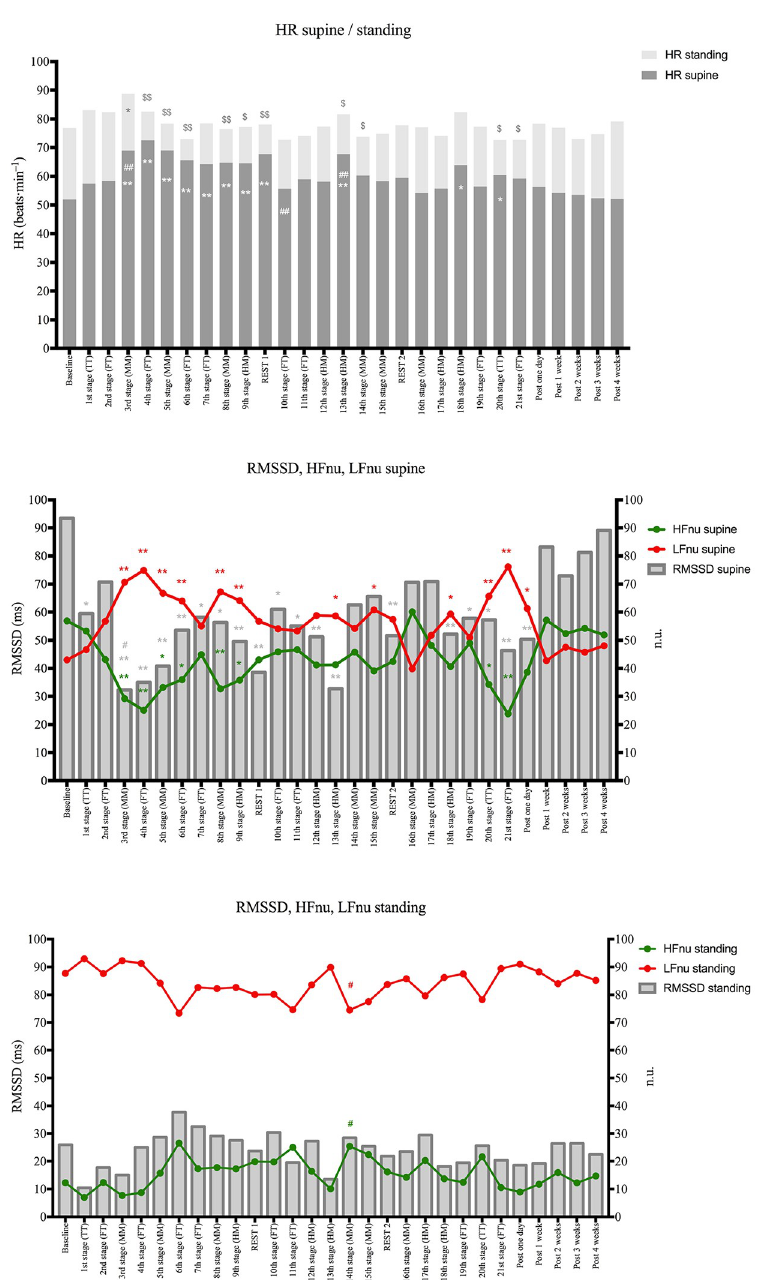
Fig 1. Evolution of Heart rate and HRV parameters stage by stage. Data are presented as mean group values. Absolute HR values different from baseline value � ( P < 0.05); different from previous stage # ( P < 0.05). HR standing- HR supine values different from baseline value $ ( P < 0.05). When reading the differences, note that all the values were recorded on the morning of each stage, which reflects the load effect of the previous stage. HR: heart rate; RMSSD: root mean square of successive differences; HF: high frequency; LF: low frequency; ms: milliseconds, n.u.: normalized units; TT: time trial; FT: flat stage; MM: medium mountain stage; HM: high mountain stage; Post: post-cycling event period.